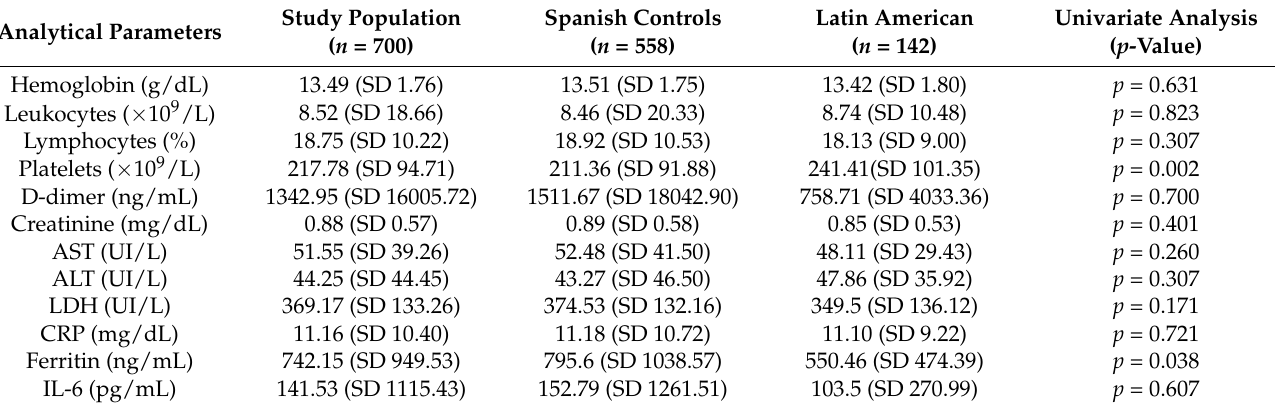
Table 3. Analytical parameters at admission in hospitalized patients with COVID-19 according to the country of origin. Analytical